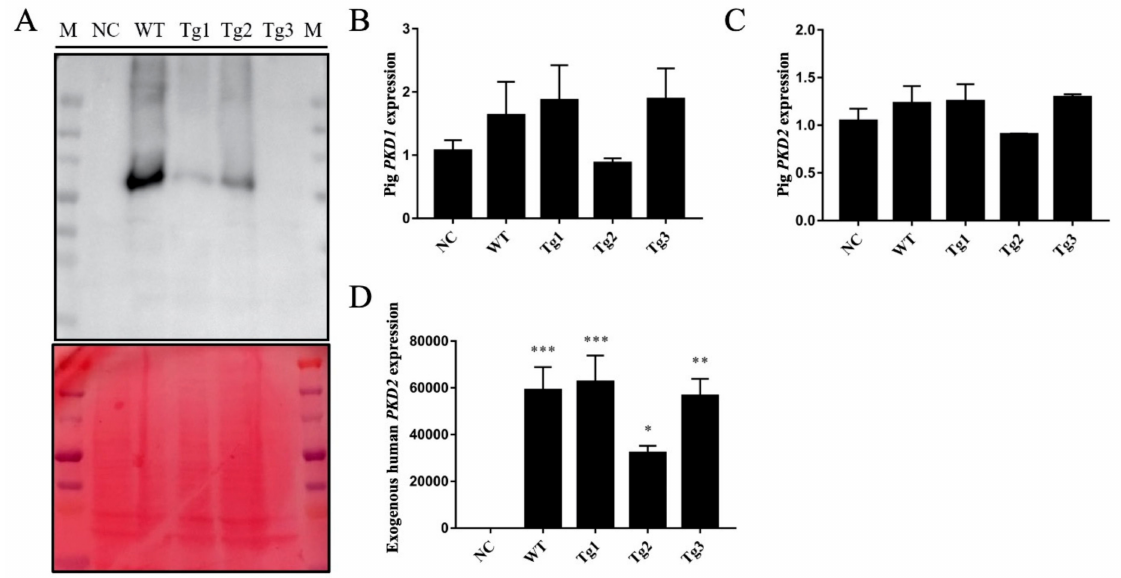
Figure 1. Validation of PKD2 overexpression in LLC-PK1 cells. ( A ) Western blot analysis of protein extracts from LLC-PK1 cells transfected with di ff erent plasmids (NC: pCAG-floxP-neo-pH11, WT: pCAG-WThPKD2-3 × FLAG-floxP-neo-pH11, Tg1: pCAG-muhPKD2 c.A1532T / p.D511V- 3 × FLAG-floxP-neo-pH11, Tg2: pCAG-muhPKD2 c.T1967G / p.L656W-3 × FLAG-floxP-neo-pH11, Tg3: pCAG-muhPKD2 c.C2224T / p.R742X-3 × FLAG-floxP-neo-pH11), showing that human PKD2 was expressed in WT-, Tg1-, and Tg2-transfected cells. Ponceau staining was used in the lower panel as loading control. ( B – D ) qRT-PCR results confirmed that endogenous pig PKD1 ( B ) and PKD2 ( c ) were not a ff ected by the overexpression of the human PKD2 gene ( D ). Data are presented as the means ± SEMs. (n = 3; * p < 0.05, ** p < 0.01, *** p <